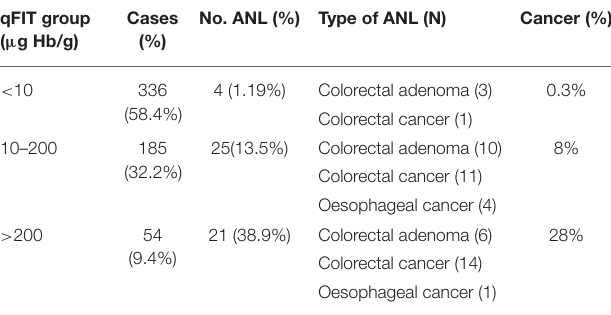
TABLE 2 | Frequency and subtype of advanced neoplastic lesion observed correlated with qFIT.